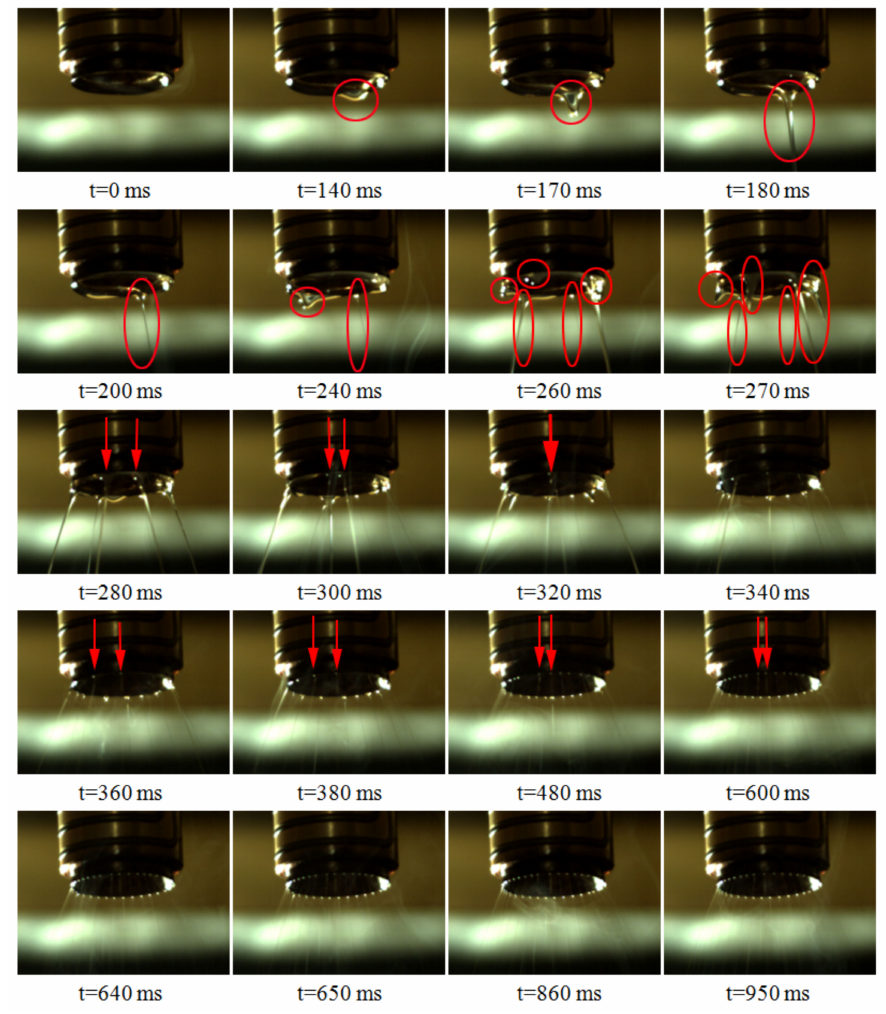
Figure 4. Photos of jets development process when the spinning voltage is 30